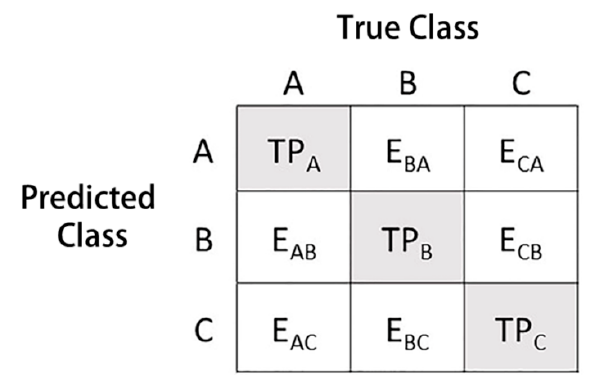
Figure 3. Confusion matrix for multiclass classification.